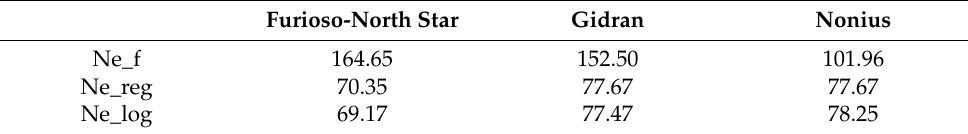
Table 7. Effective population size in the reference